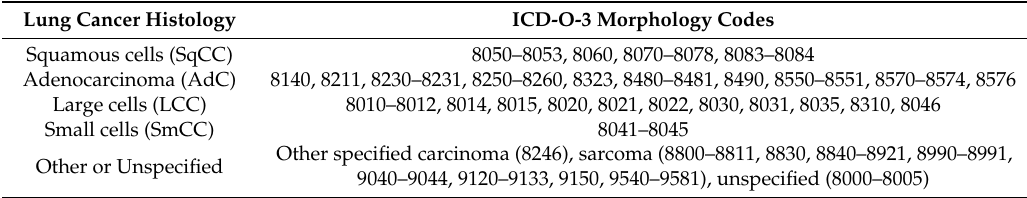
Table 1. Classification of incident lung cancers by